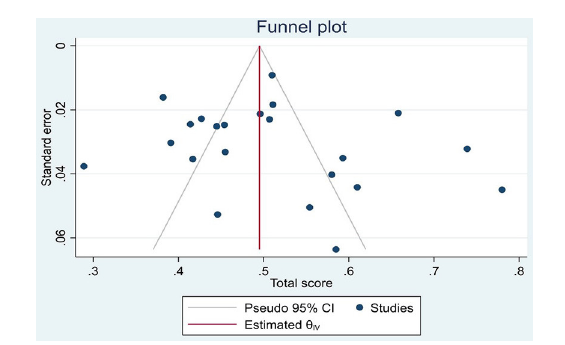
FIGURE2 Forest plot showing the pooled scores on PU prevention based on the target group.